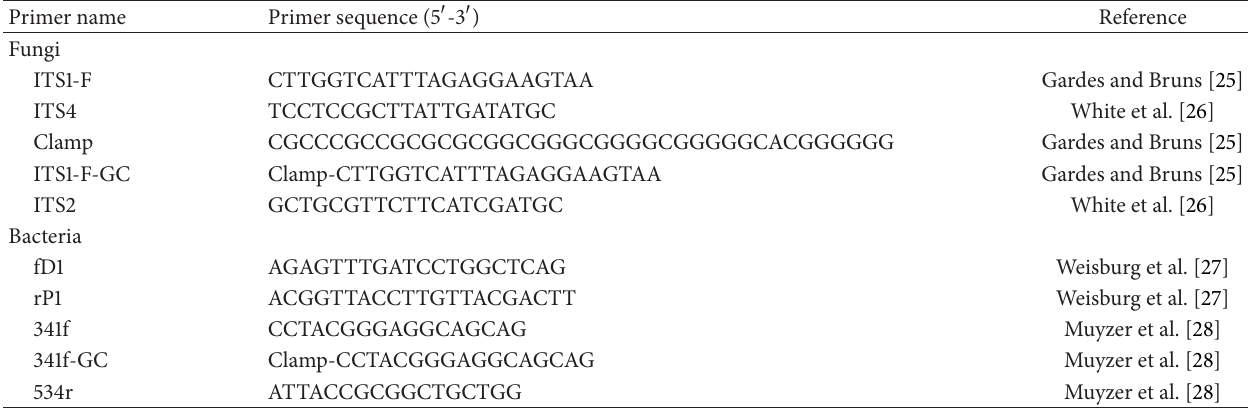
Table 1: Primers used for nested PCR amplification of soil fungal and bacterial communities in the rhizosphere of Pinus tabulaeformis